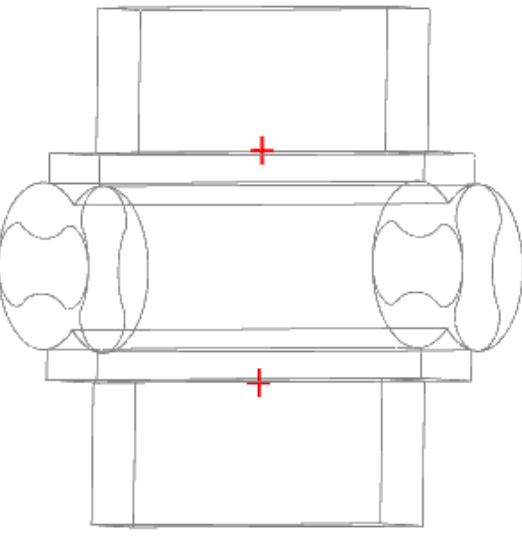
Figure 6. Position of the monitoring points.